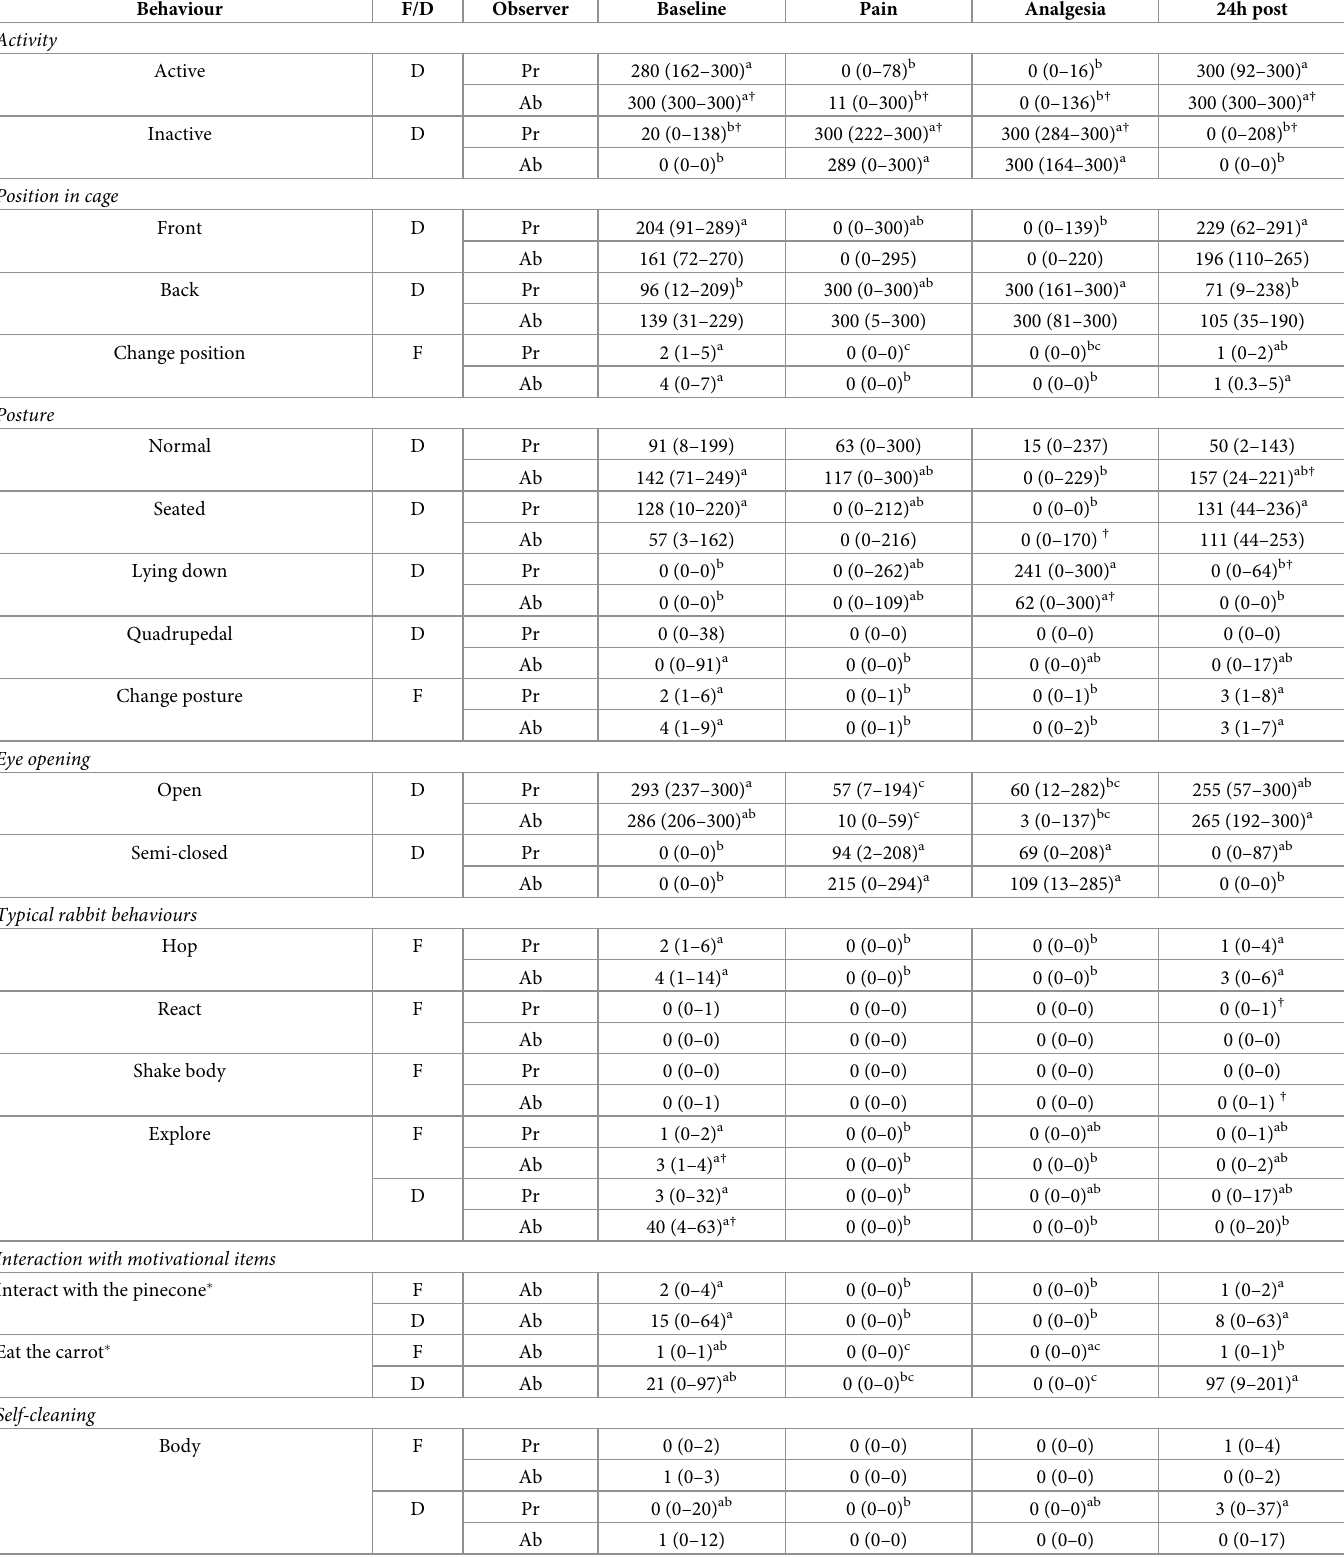
Table 3. Median and interquartile range (Q1 –Q3) of behaviour of 28 rabbits that altered over time or between the presence and absence of